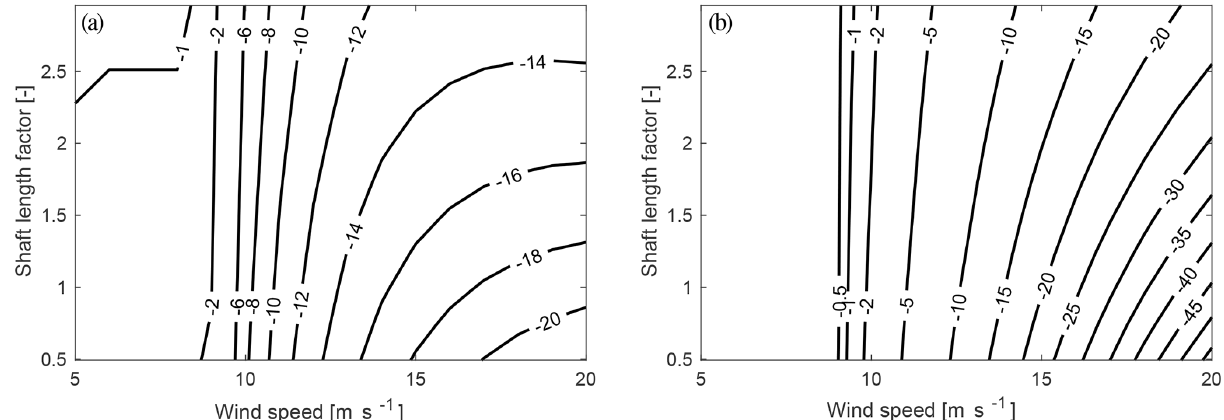
Figure 9. Equilibrium yaw angle ( ◦ ) (a) and the relative difference in power production (%) (b) depending on shaft length and wind speed variation for a turbine configuration with 5 ◦ tilt and 3.5 ◦ cone. The relative, difference in power is compared at each calculation point relative to the power production of the original turbine, with a forced yaw